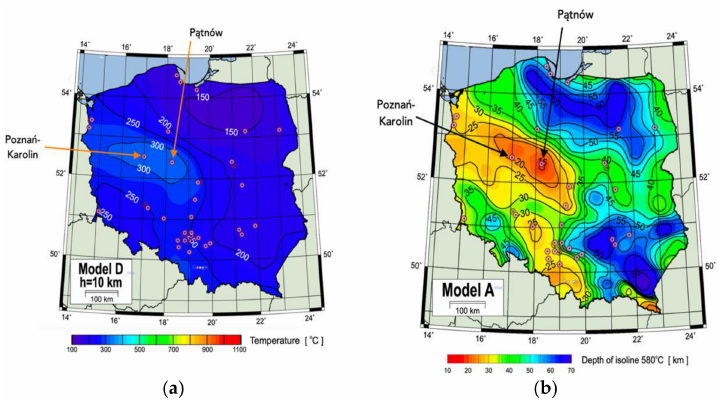
Figure 9. Coal unit and heat map overlay at 10 km depth ( a ) and 580 ◦ C ( b )